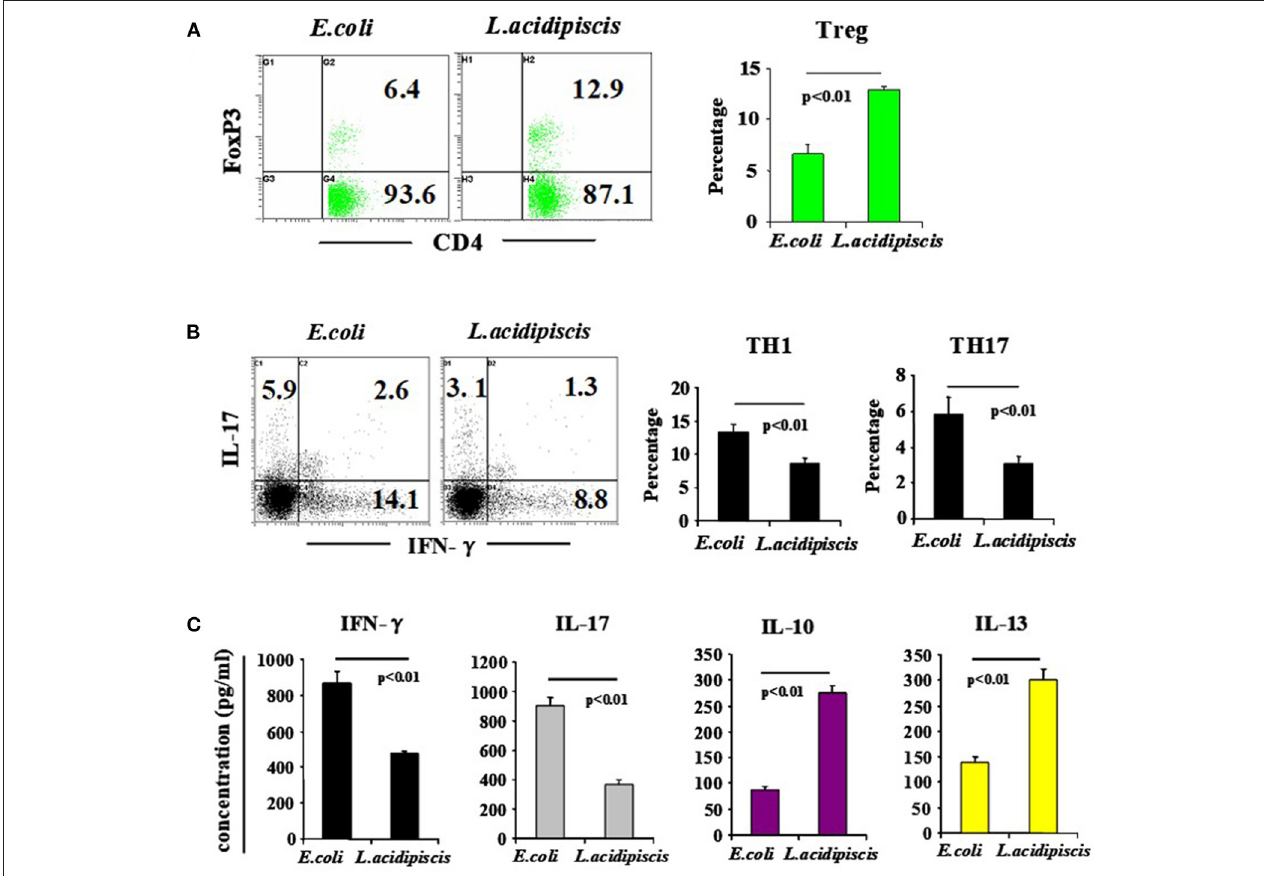
FIGURE 4 | L. acidipiscis induced the development of Treg cells and inhibited pathological differentiation into Th1 and Th17 cells. Percentages of CD4 + T cells consisting of Treg, Th1 and Th17 cells in mesenteric lymph nodes of C57BL/6 mice fed with bacteria were determined on day 15 when EAE symptoms peaked. (A) FACS detection of CD4 + FOXP3 + Treg cells, and percentage of CD4 + T cells consisting of Treg cells. (B) FACS detection of Th1 and Th17 cells, and percentage in CD4 + T cells. (C) Cytokine concentration in cell culture supernatant. Representative flow cytometry plots were derived from a single experiment with 5 mice per experimental group and average percentage of each subset was expressed as mean ± SEM from three independent experiments. Statistical differences were determined by using Student’s t -test, and data with P < 0.01 represent significant differences between the two